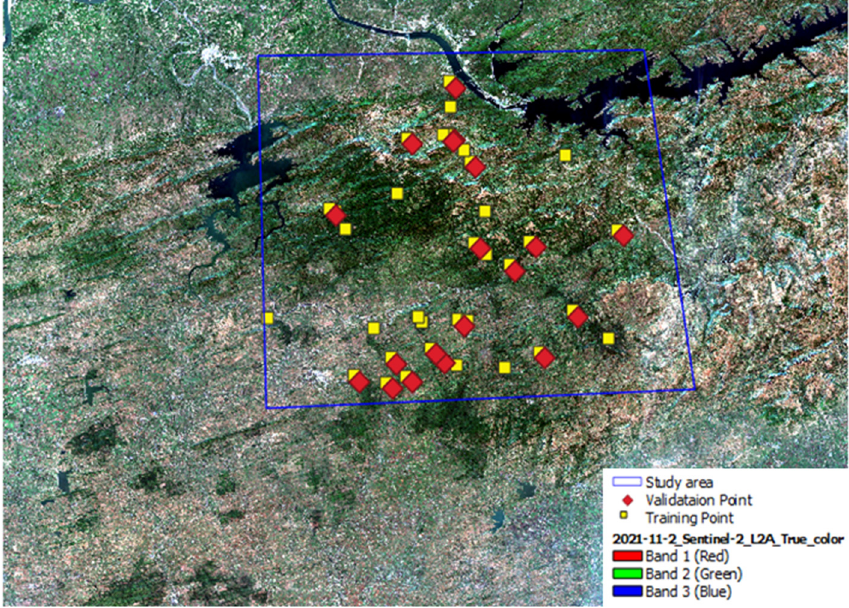
Figure 1. True color composite (665, 560, 443 nm, RGB) of Shoolpaneshwar Wildlife Sanctuary derived from Sentinel-2A data. Blue box shows study area.